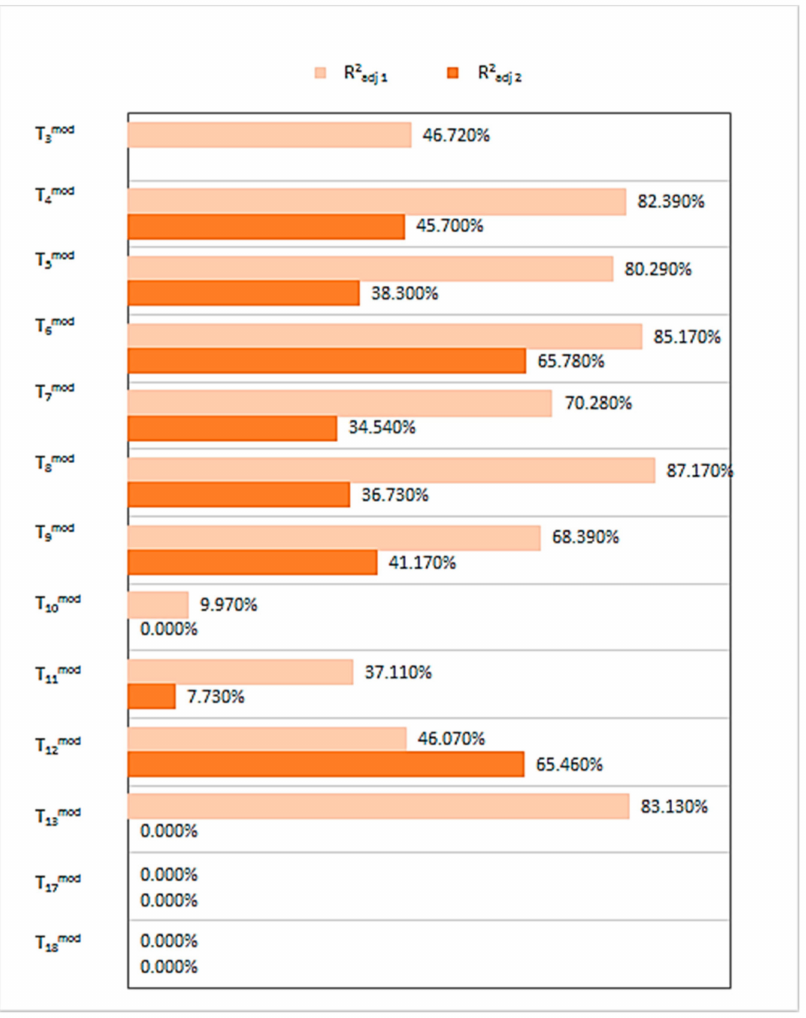
Figure 12. Values R 2 of proposed regression models for the first phase— R 2 adj phase— R 2 (Source: own adj 2